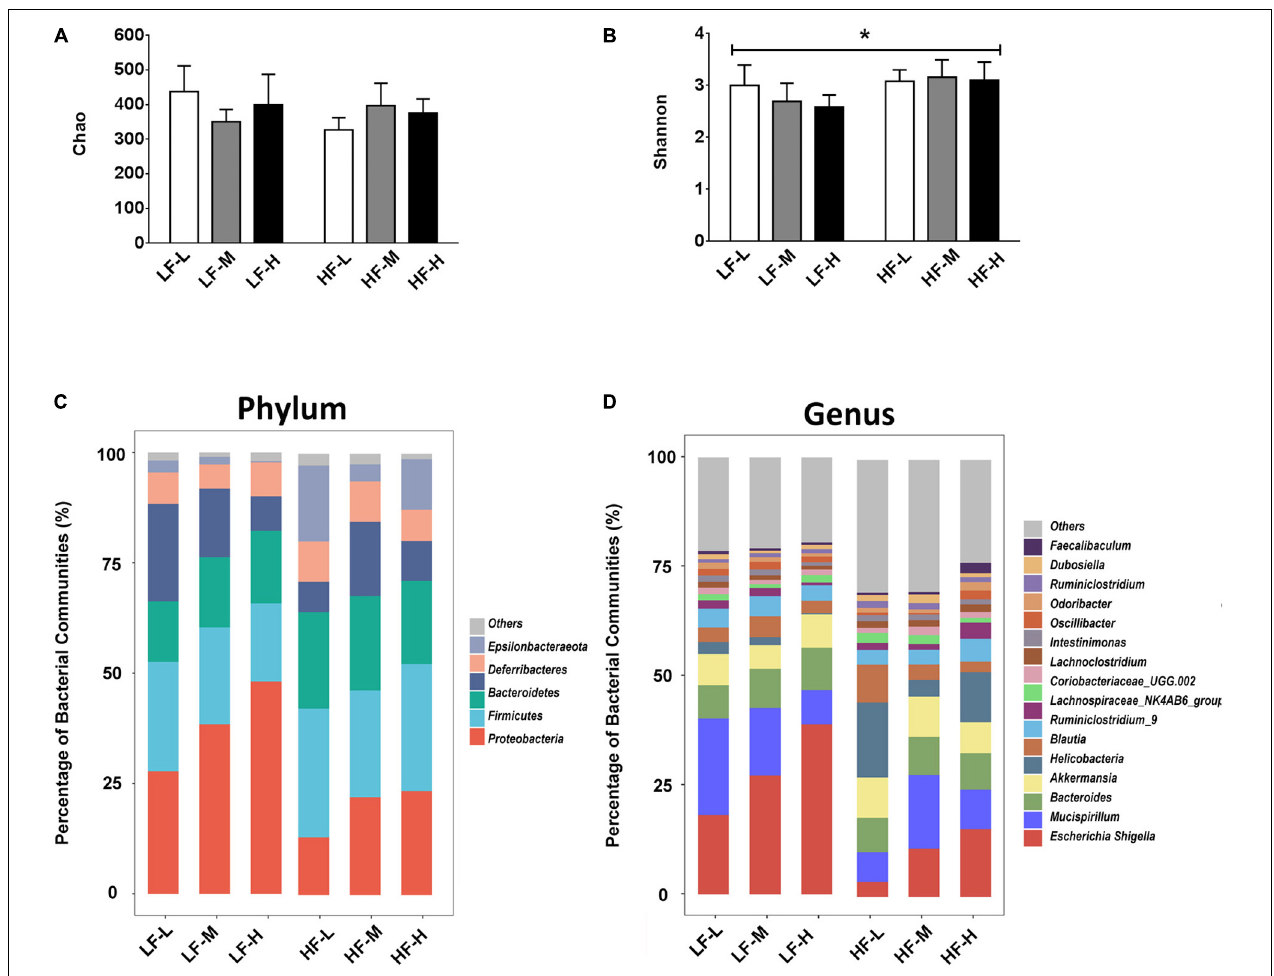
FIGURE 4 | (A) Bacterial richness of gut microbiota evaluated by Chao index. (B) Bacterial diversity of gut microbiota estimated by Shannon index. (C) Compositions of gut microbiota in different groups at phylum level, and (D) compositions of gut microbiota in different groups at genus level. Asterisk indicates a significant difference between the high fat diet groups and low fat diet